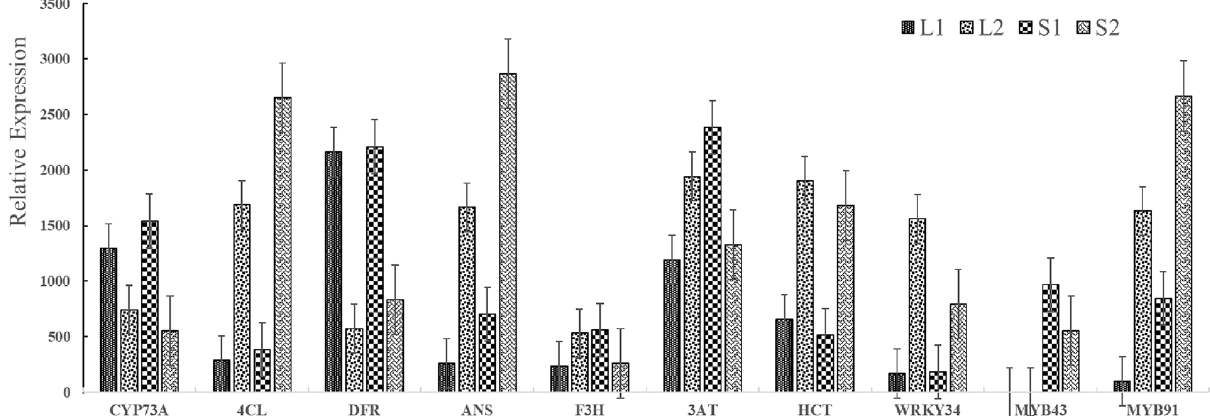
Figure 7. Expression levels of 10 genes involved in the flavonoids biosynthetic pathway by qRT-PCR analysis.